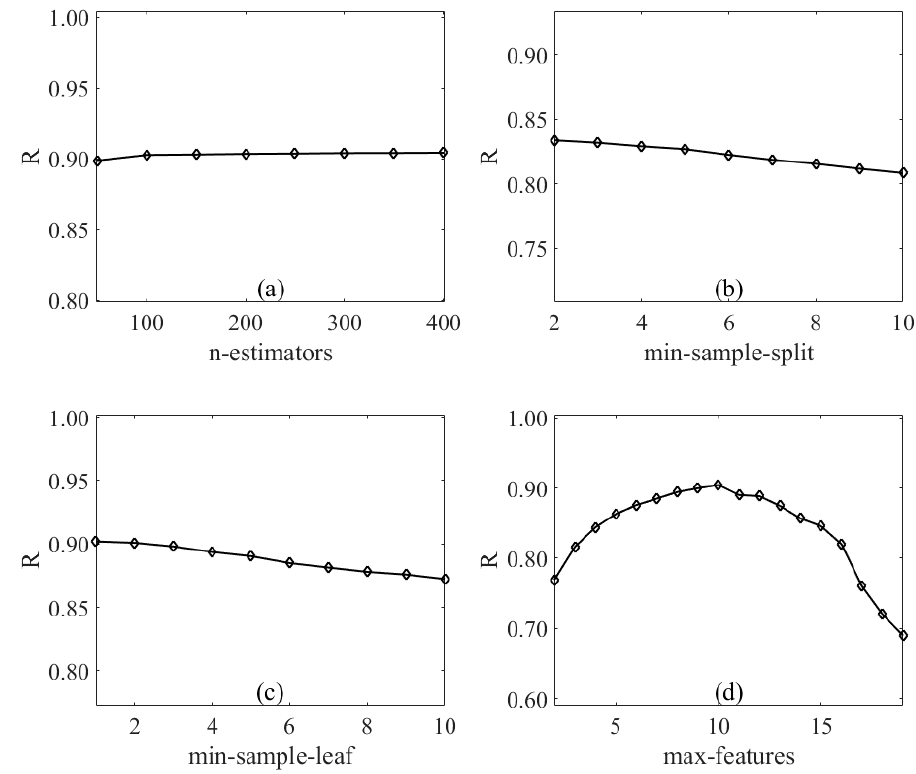
Figure 3. Sensitivity analysis of R values to the ( a ) n-estimators; ( b ) min-sample-split; ( c ) min-sample-leaf; ( d ) max-features of the RF method.